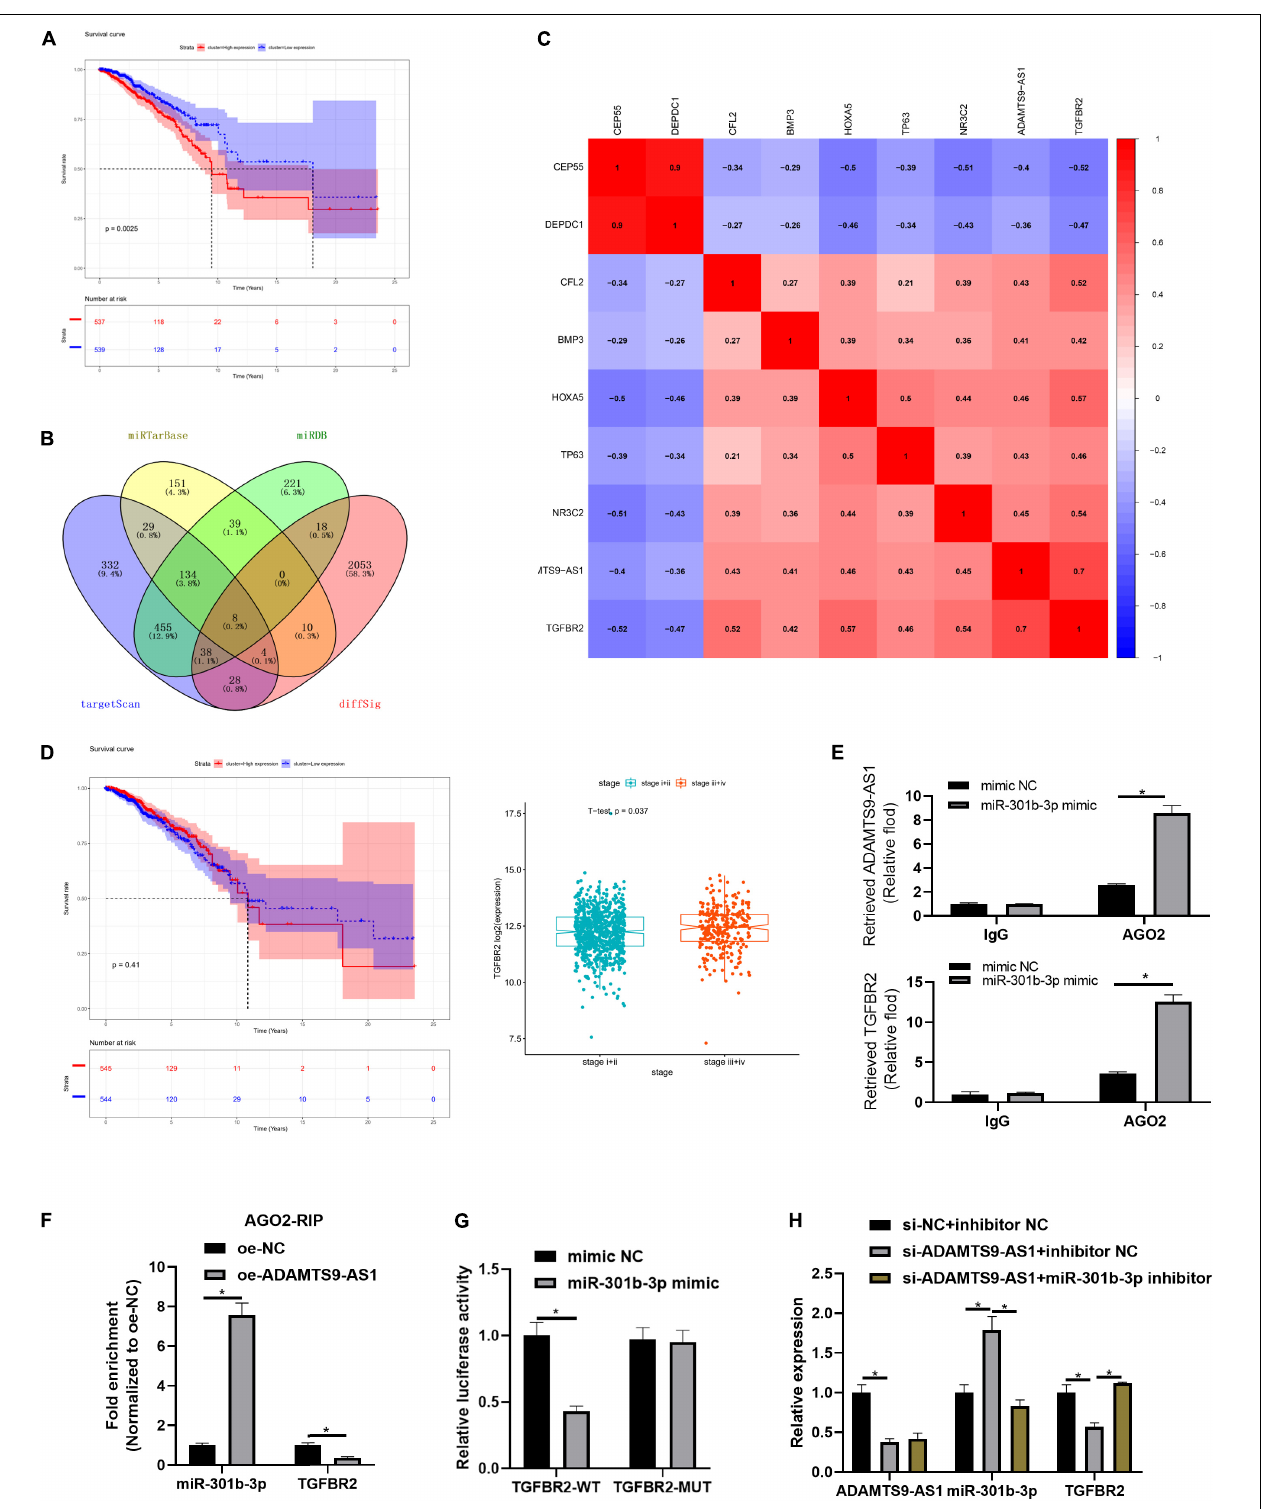
FIGURE 3 | ADAMTS9-AS1 competitively binds to miR-301b-3p to promote TGFBR2. (A) Survival curve of miR-301b-3p level and prognosis of patients. (B) Venn plot of predicted mRNAs and DEmRNAs; diffSig denotes differentially expressed genes screened from TCGA database. (C) Association between ADAMTS9-AS1 and 8 target mRNAs. (D) The survival curve of TGFBR2 expression level on the prognosis of patients. (E,F) Results of RIP method. (G) Result of dual-luciferase method. (H) The expression of ADAMTS9-AS1, miR-301b-3p and TGFBR2. * p < 0.05.